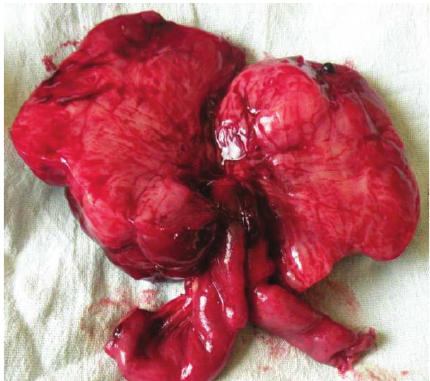
Figure 4: Cut section of the mass with the resected part of proximal